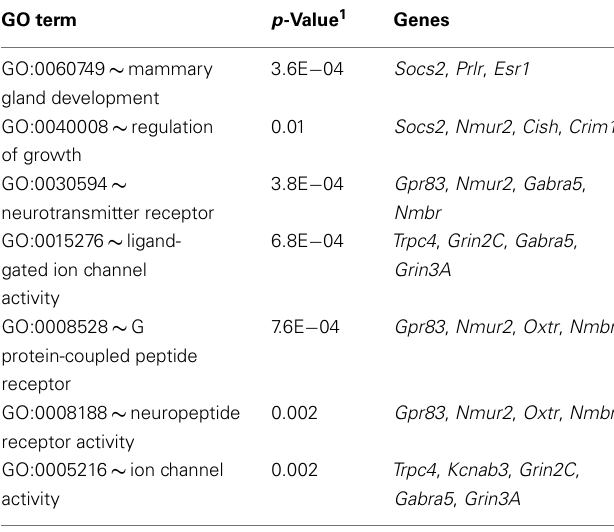
Table 2 | Enriched gene functions among autosomal transcripts with sex differences in the